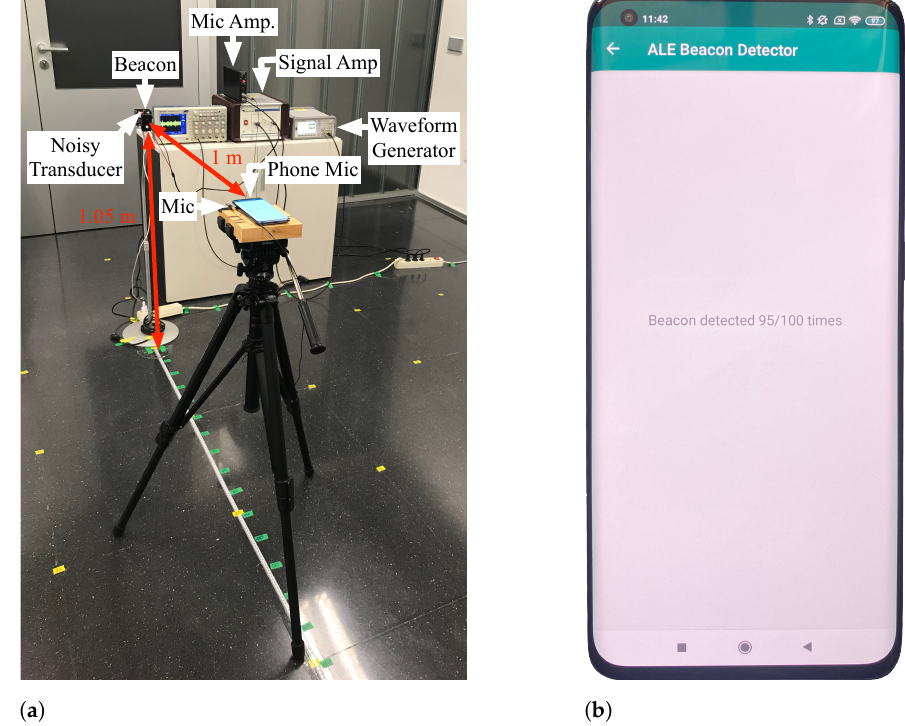
Figure 6. Noise tolerance experiment. ( a ) Experimental setup. ( b ) Android application interface.